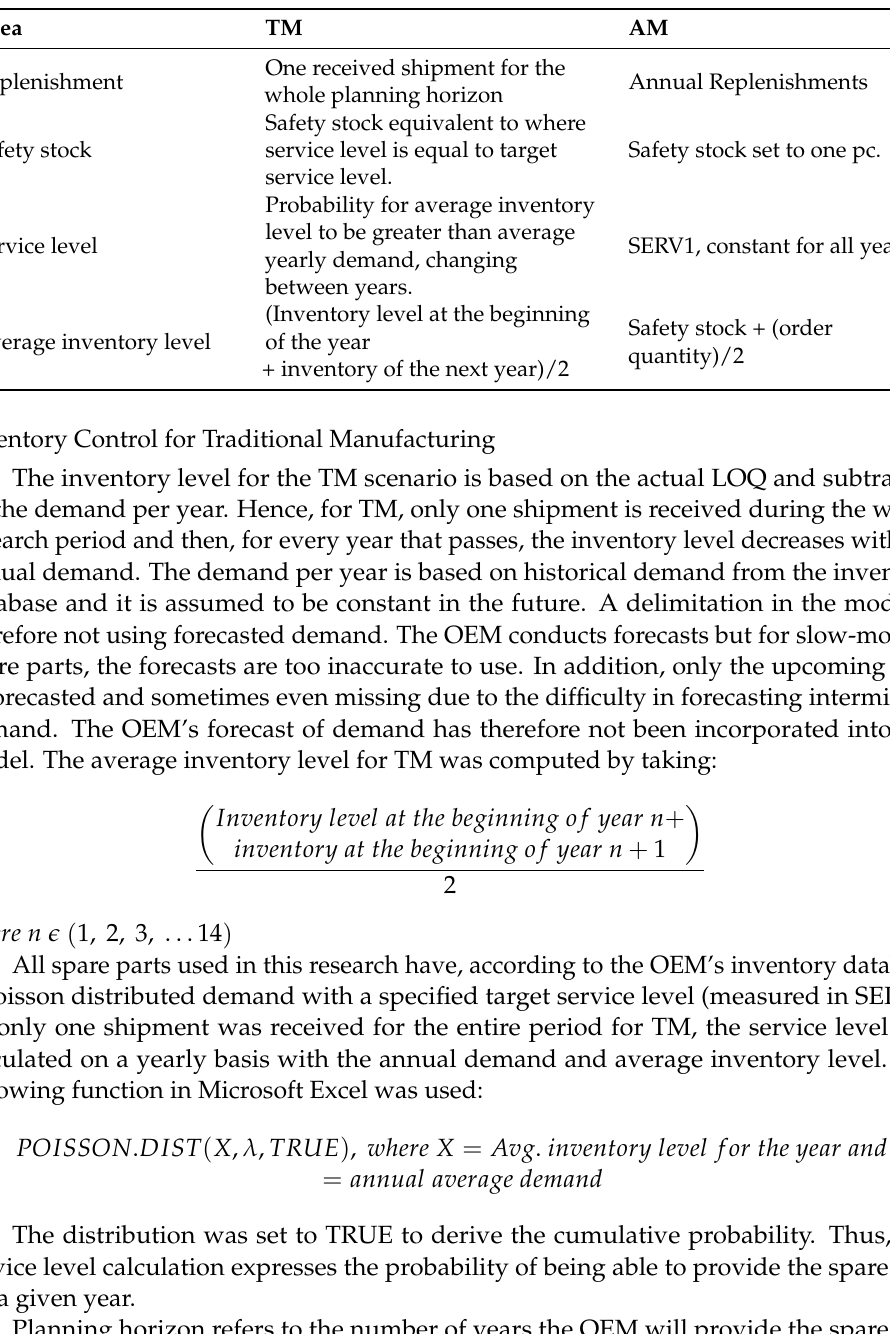
Table 4. Comparison between inventory control of TM and AM in the